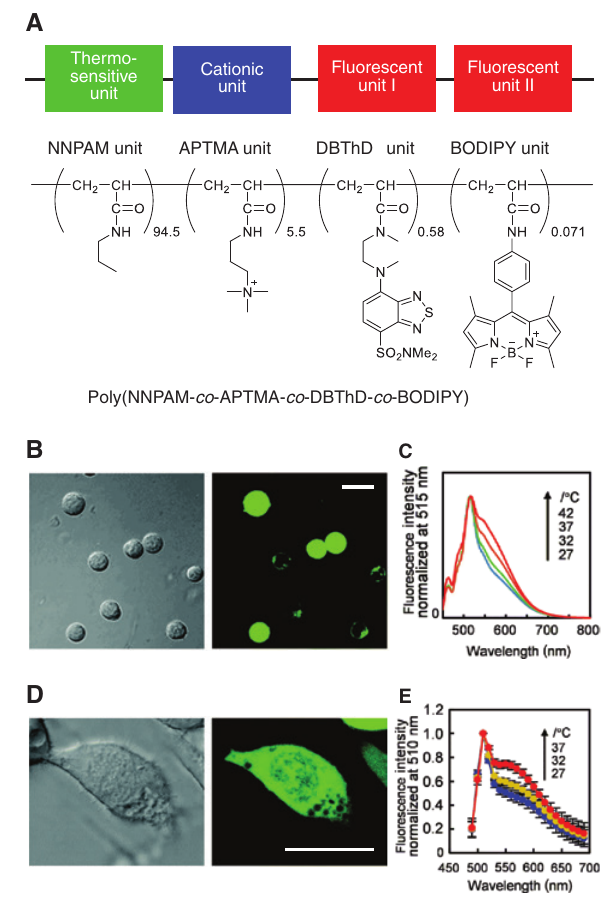
Figure 6: Intracellular thermometry of living mammalian cells using ratiometric poly(NNPAM- co -APTMA- co -DBThD- co -BODIPY) = 20,300, M = 10,800, M = 1.88). ( M / M w n w n (A) Chemical structure of poly(NNPAM- co -APTMA- co -DBThD- co - BODIPY). (B) Representative images of MOLT-4 cells treated with poly(NNPAM- co -APTMA- co -DBThD- co -BODIPY). Differential interfer- ence contract (DIC) image (left) and confocal fluorescence image (right). Scar bar = 20 μ m. (C) Fluorescence spectra of poly(NNPAM- co -APTMA- co -DBThD- co -BODIPY) in living MOLT-4 cells at 27, 32, = 458 nm). (D) Representative images of HEK293T 37, and 42 ° C ( λ ex cells treated with poly(NNPAM- co -APTMA- co -DBThD- co -BODIPY). DIC image (left) and confocal fluorescence image (right). Scar bar = 20 μ m. (E) Averaged fluorescence spectra of poly(NNPAM- co -APTMA- co -DBThD- co -BODIPY) in a single HEK293T cell (n = 9, mean ± SD) at = 473 nm). Reproduced with permission 27, 32, and 37 ° C ( λ ex